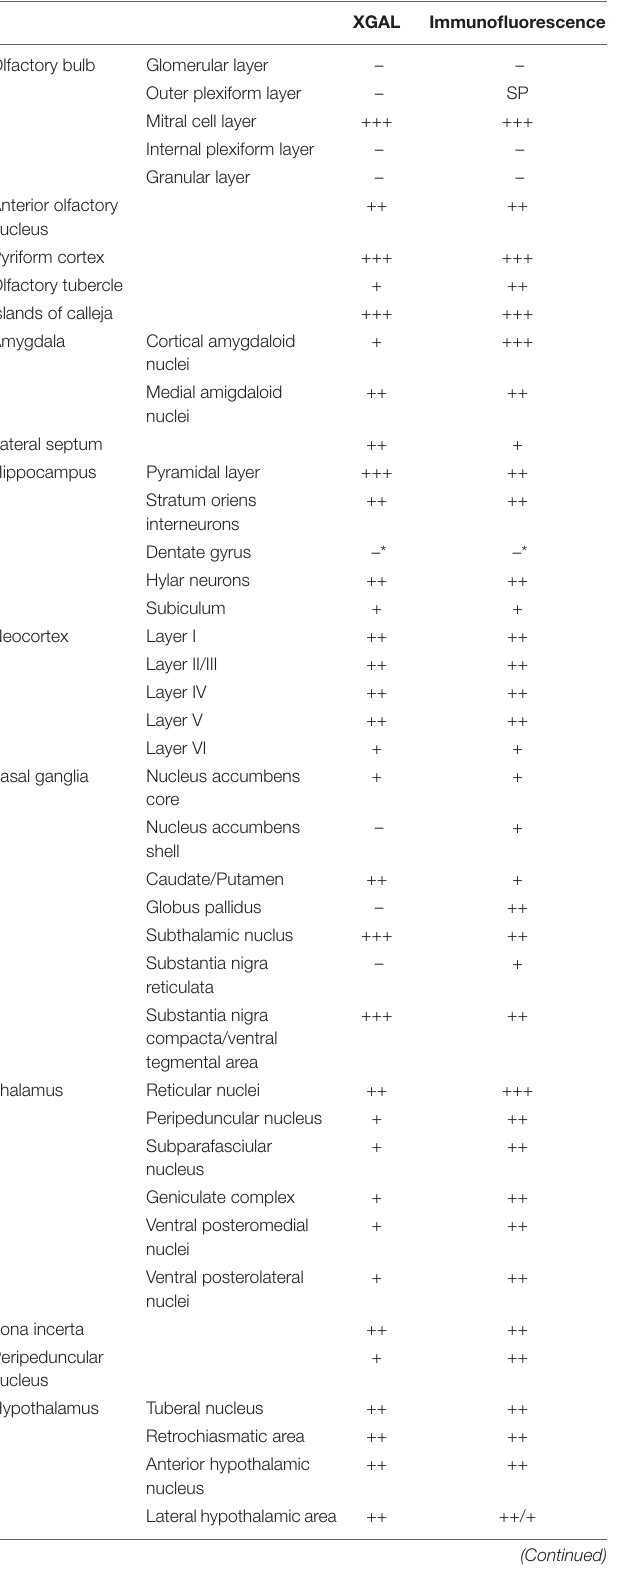
TABLE 1 | Levels of expression of the ELovl5 gene (XGAL) and of the Elovl5 protein (immunofluorescence) in the central nervous system. XGAL